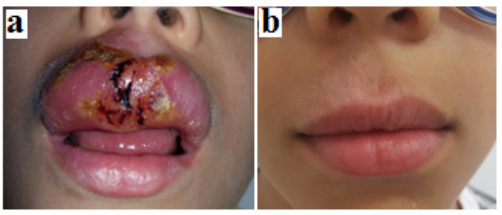
Figure 2. Hyperemic and pruritic lesion on the upper lip, reported at Case-4 ( a ); Aspect of the upper lip one month later, evidenced remission of lesion ( b